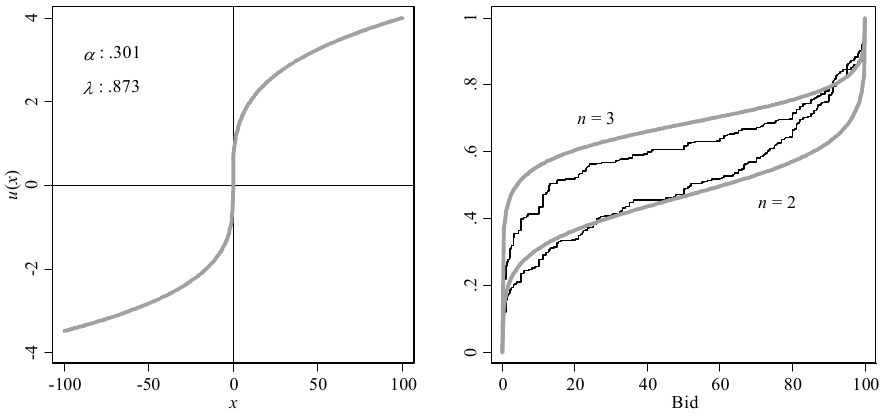
Figure 5. Left panel: Prospect theory value function with estimated parameters. Right panel: Observed (bold lines) and predicted (thin lines) cumulative densities for both group